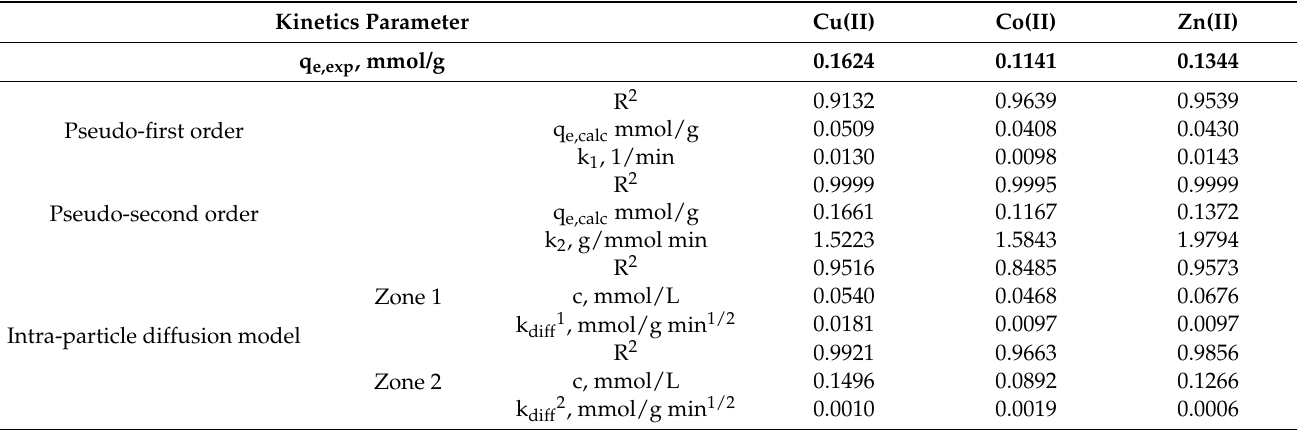
Table 4. Kinetic parameters for Cu(II), Co(II) and Ni(II) ions biosorption on Alg-Fe 3 O 4 -MPs. Kinetics